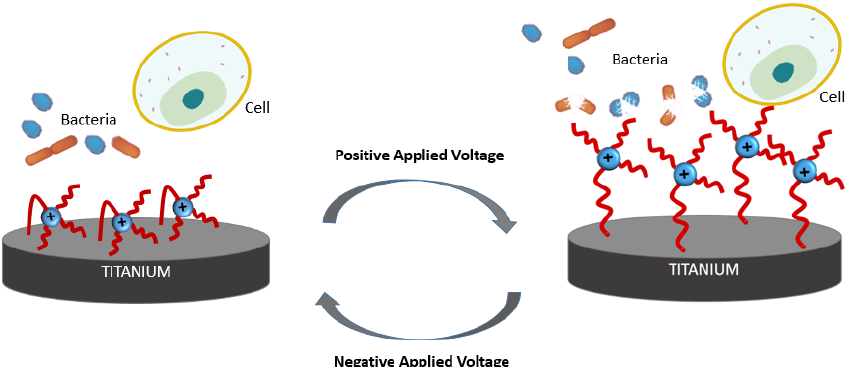
Figure 1. Schematic representation of electrically responsive biocidal surface based on phosphonium self-assembled monolayers.